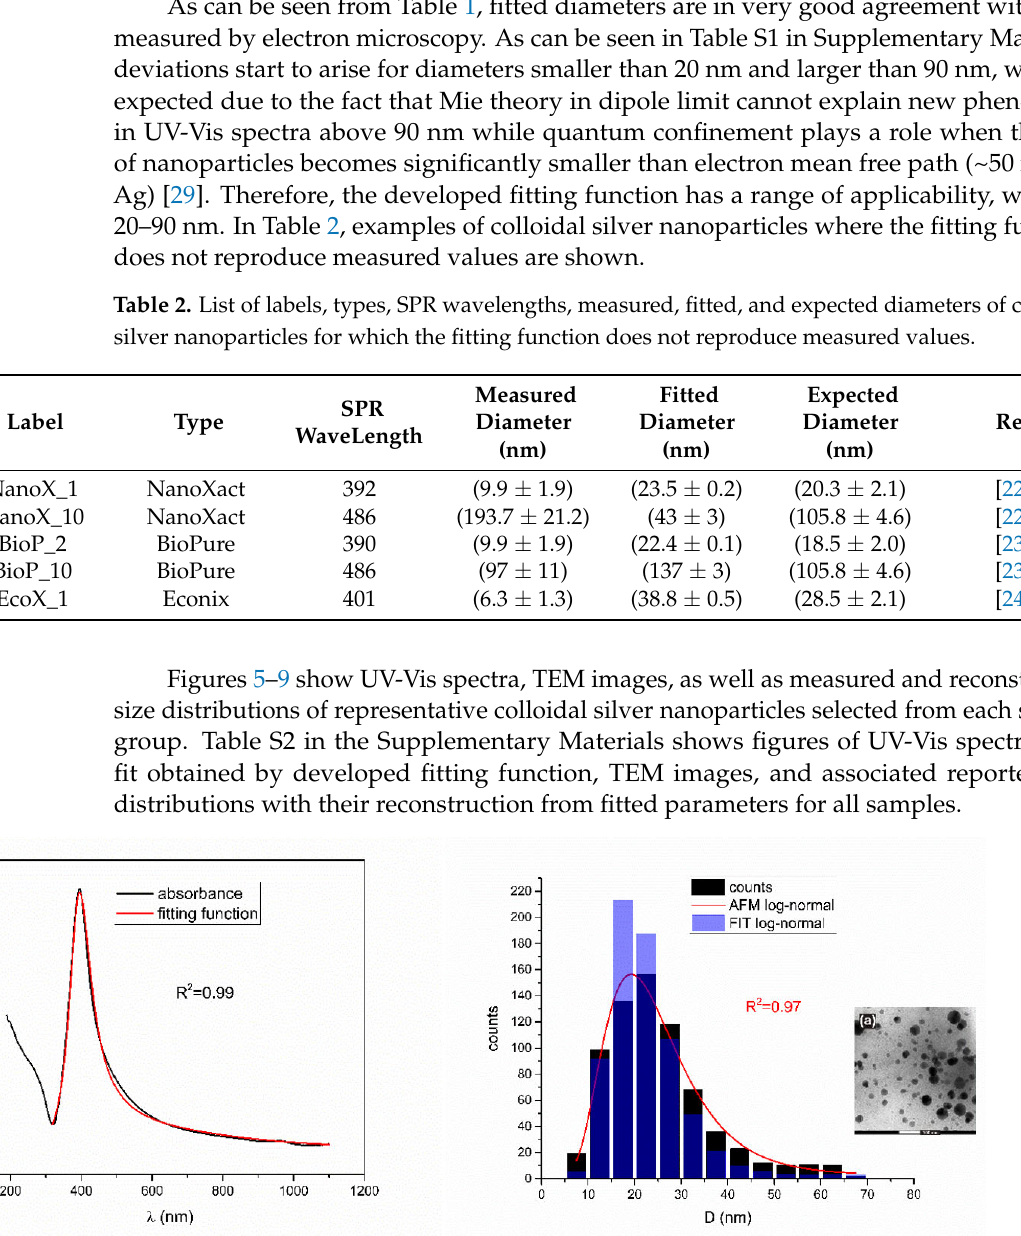
Figure 6. UV ‐ Vis spectrum with fitting function ( left ) for sample NanoX_6. Reported and recon ‐ structed size distributions are shown on the right . An additional TEM image is also shown.